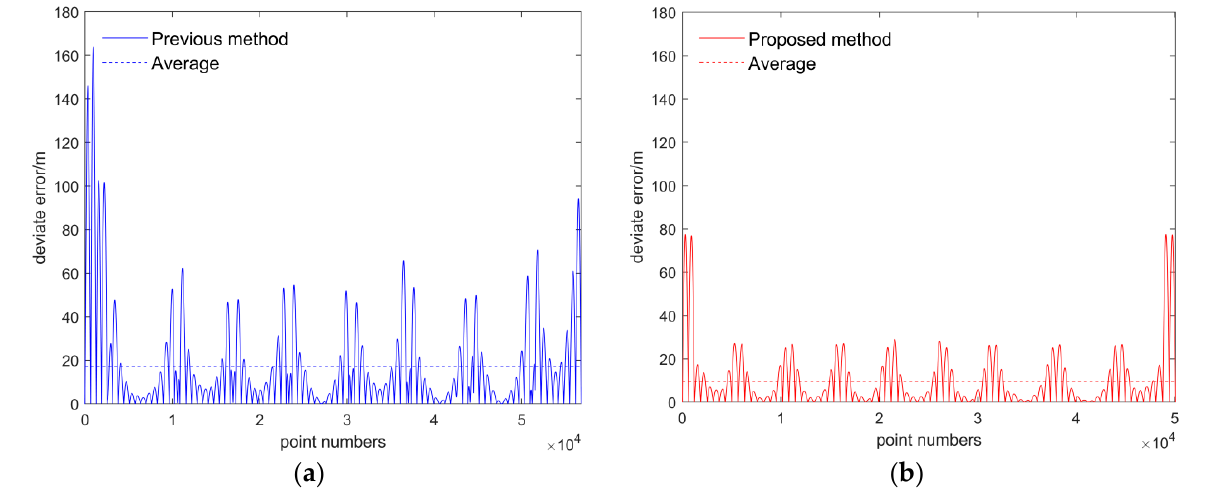
Figure 12. Deviation distance between the path and the trajectory. ( a ) Deviation distance generated by the previous methods. ( b ) Deviation distance generated by the proposed methods. Table 4. Proportion of distribution range of deviation distance.